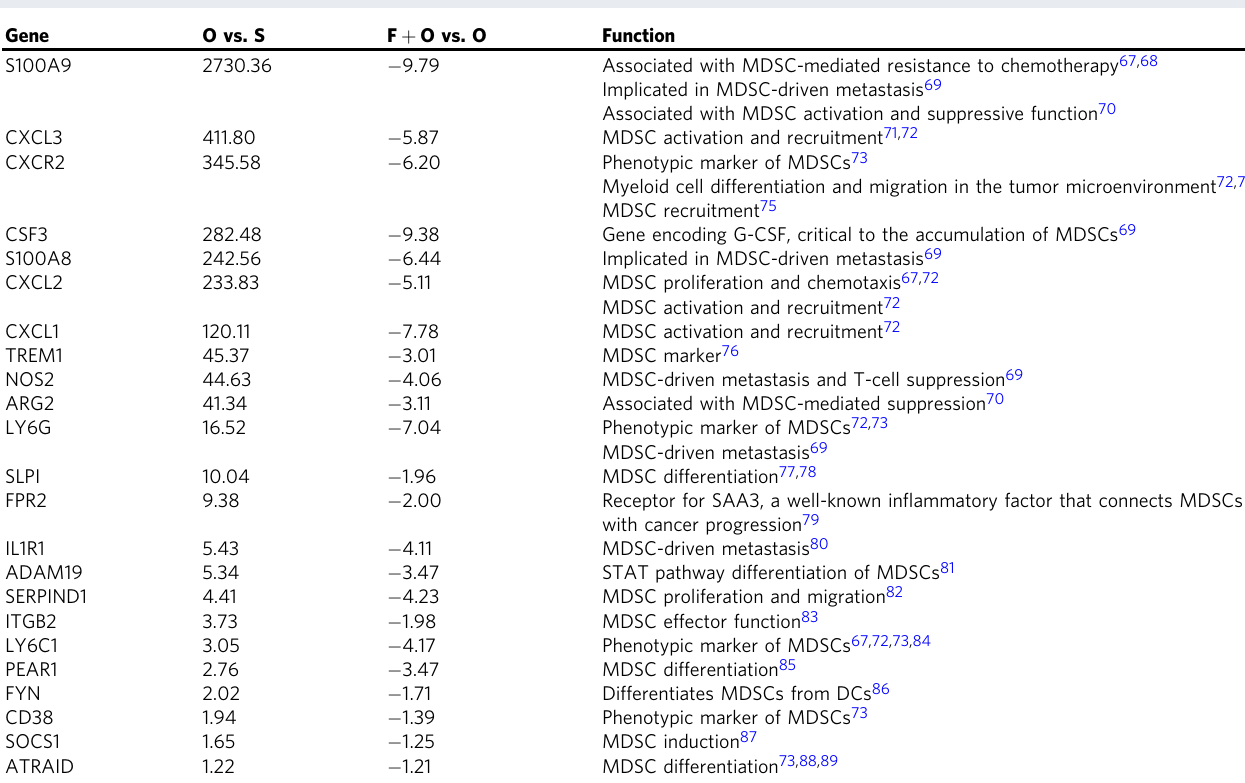
(Table 1) in a combined cohort of publicly available clinical microarray data 34 . Mean expression of this signature above median was associated with worse overall survival (OS) in p value = 0.031] (Fig. 7f), and generally across all breast cancer